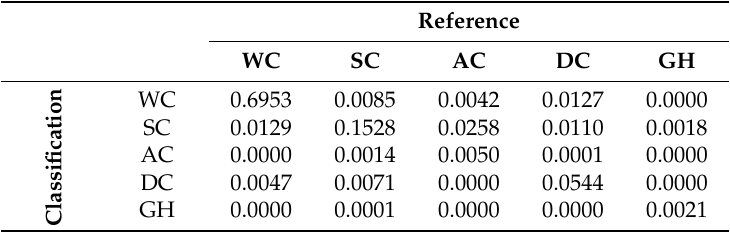
Table A1. Confusion matrix for variable subset “ALL”. Cells populated with adjusted probabilities [54]. WC: winter cropping, SC: summer cropping, AC: semi-aquatic cropping, DC: double-cropping, GH: greenhouse cultivation.